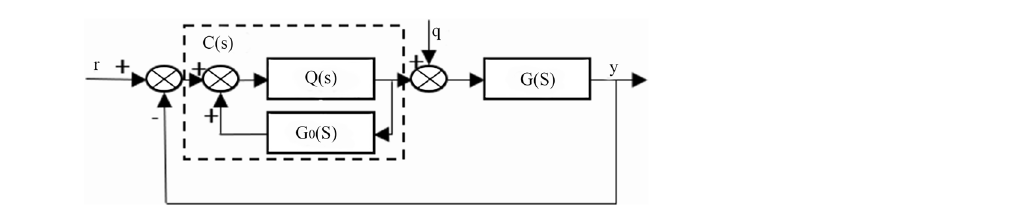
Figure 11. Structure of the equivalent feedback control